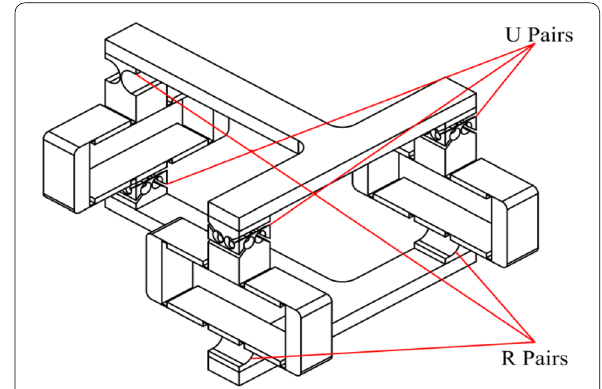
Figure 7 The obtained RPR compliant mechanism